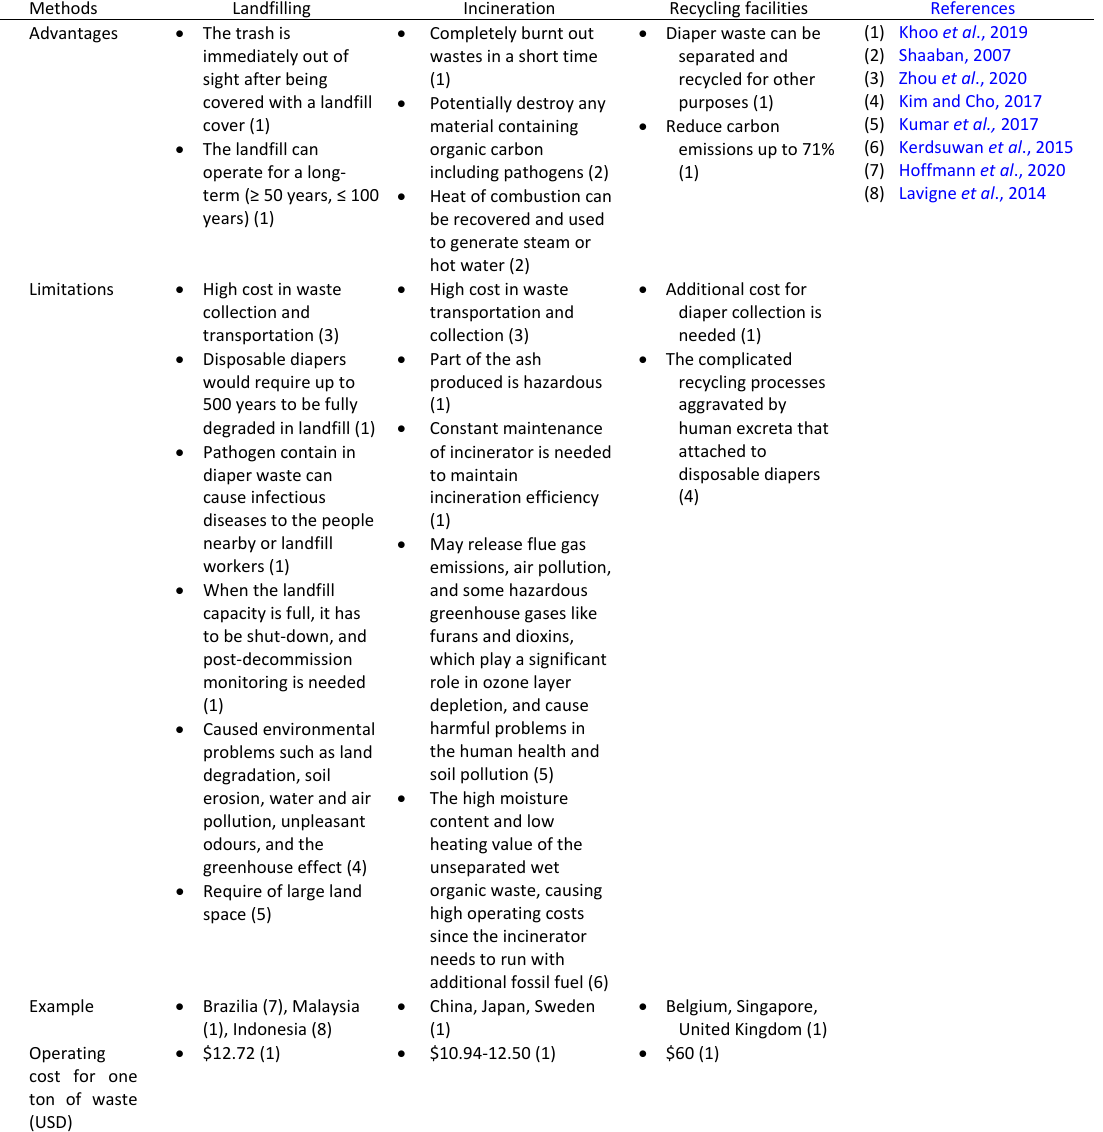
Table 1: Summary of Conventional Disposal Methods for Disposable Diaper